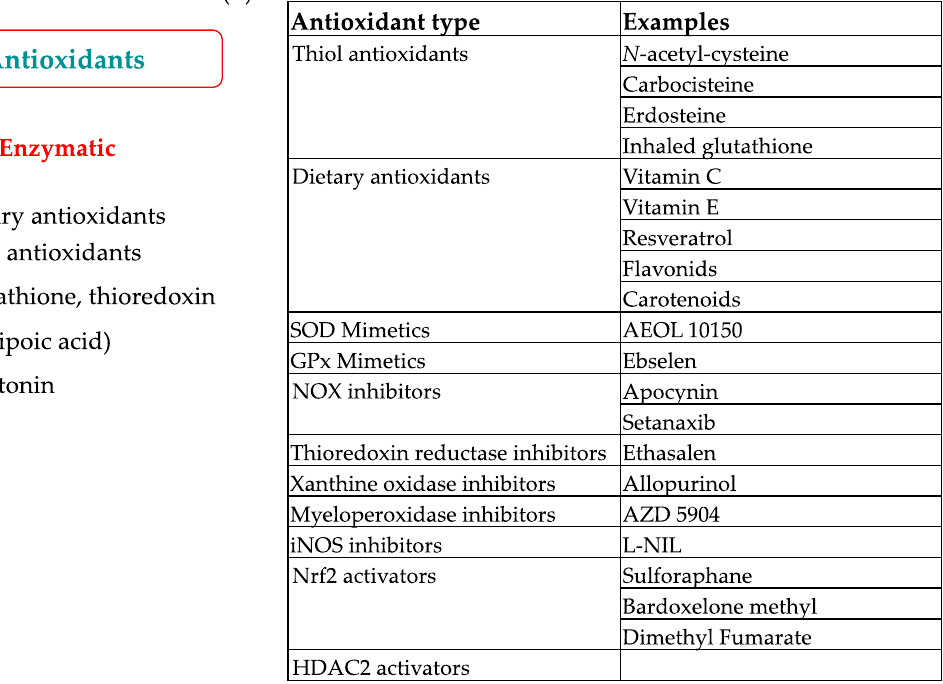
Figure 3. Antioxidants. ( A ) Classification of enzymatic and non-enzymatic antioxidants and ( B ) Examples of antioxidants for COPD and asthma